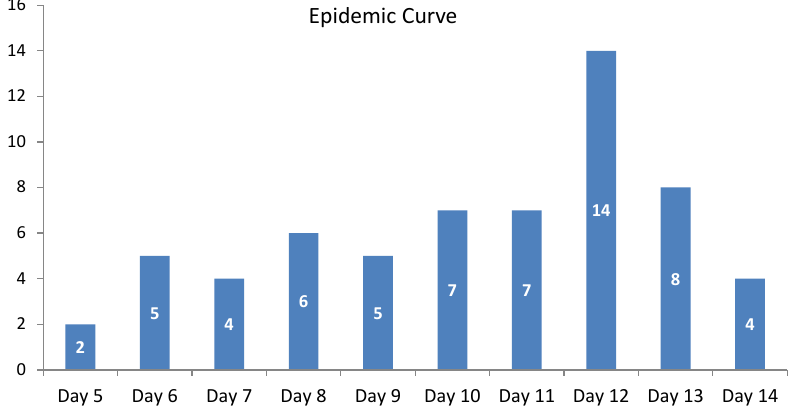
Figure 1. Epidemic Curve of Wilderness/Backcountry Diarrhea (n =